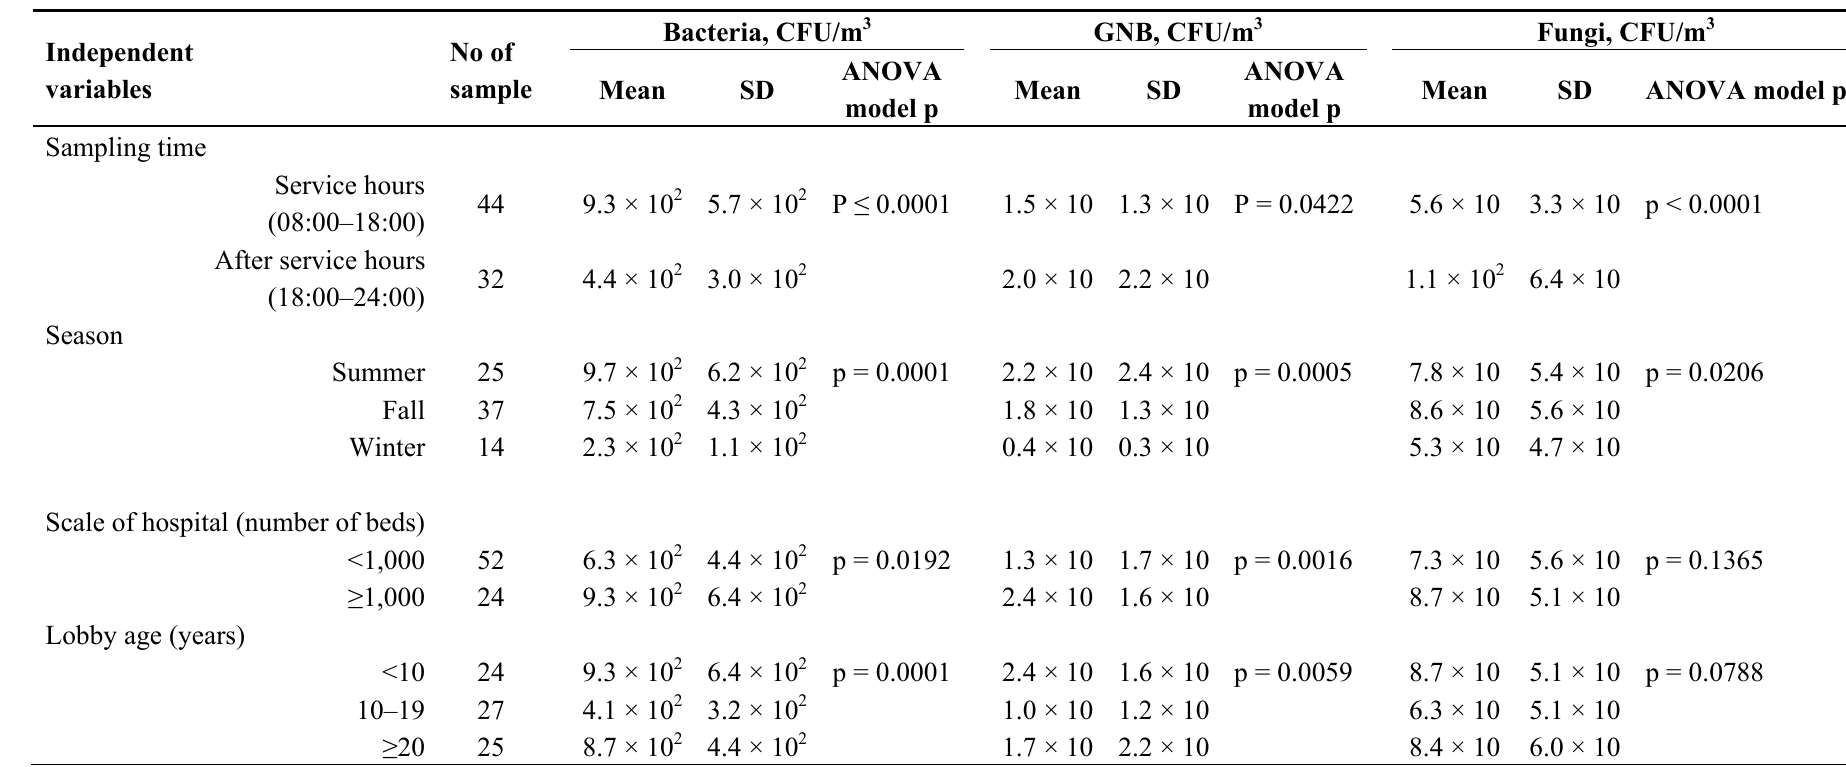
Table 5. The levels of log-transformed bacteria, gram-negative bacteria, and fungi among the categories of occupational and environmental variables.